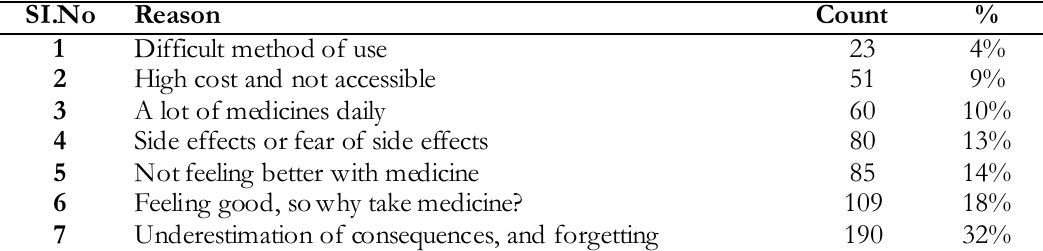
Table 3: Distribution of causes for patient non-compliance in Aseer region SI.No